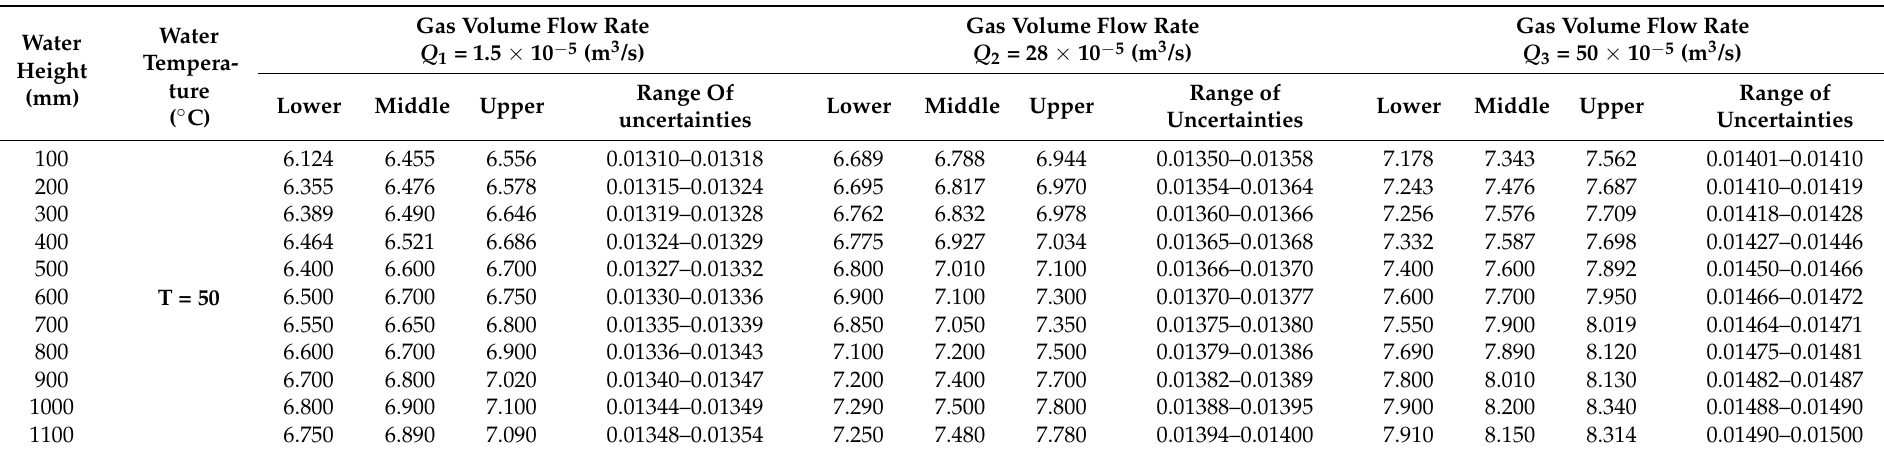
Table 5. Bubble diameter (mm) as a function of water height for T = 50 ◦ C and for gas volume flow rates Q 1 –Q 3